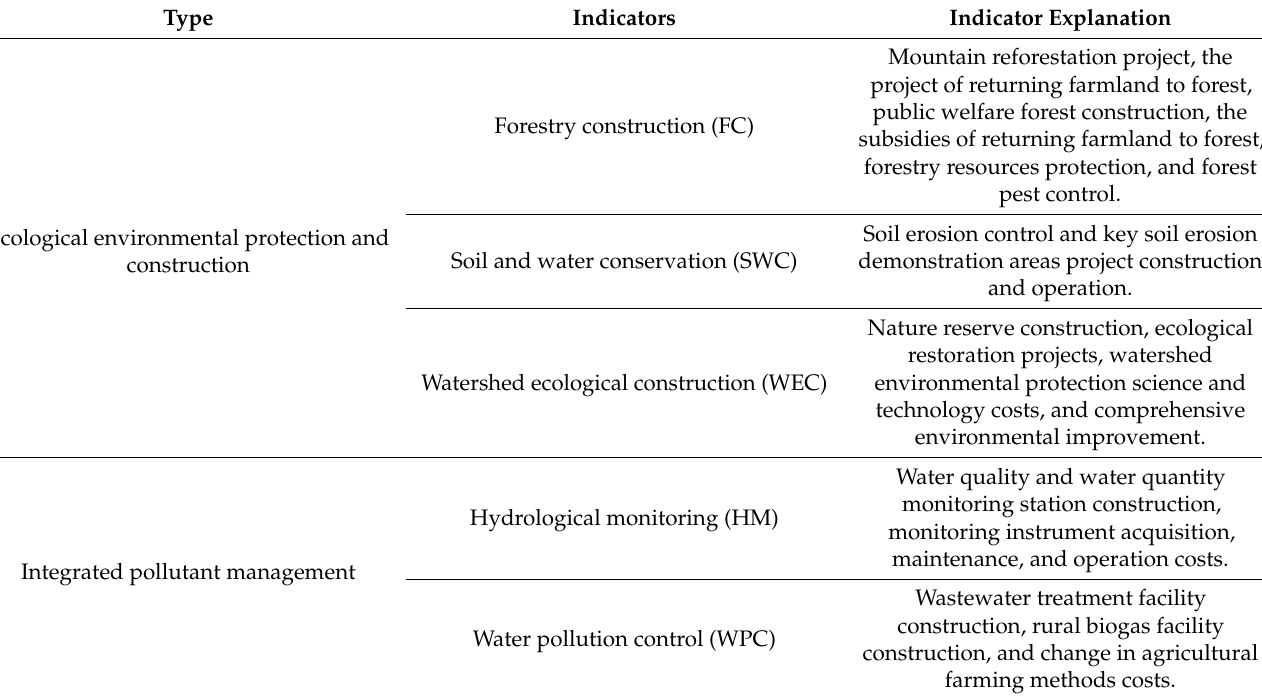
Table 2. Types and indicator explanation of direct